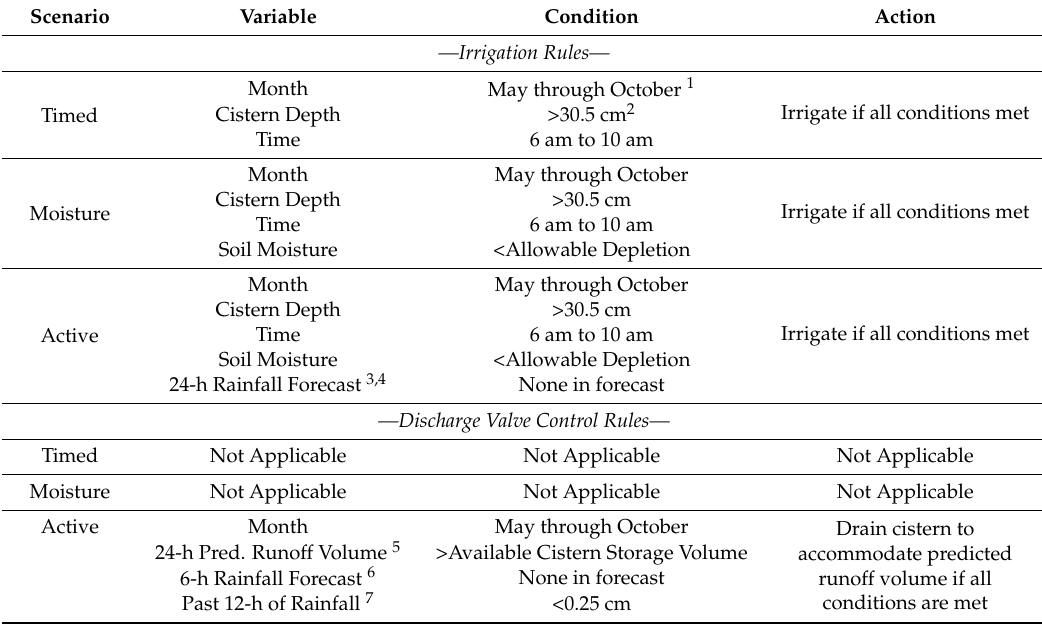
Table 3. Model scenario based logic